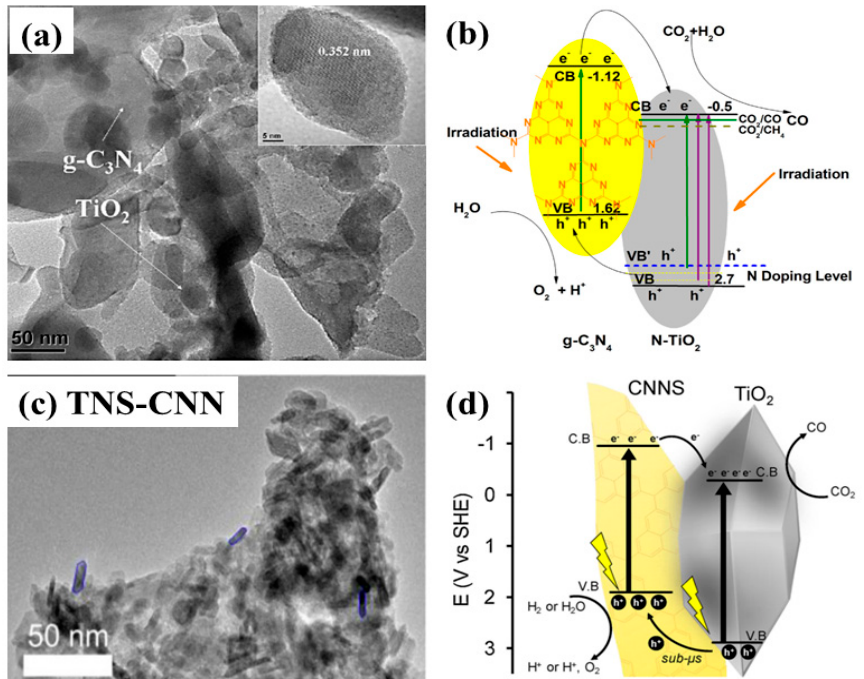
Figure 7. ( a ) TEM image showing the loading of N-TiO 2 nanoparticles onto g-C 3 N 4 nanosheets, and ( b ) proposed scheme involved in photocatalytic CO 2 conversion (taken with permission from [62]). ( c ) TEM image showing the 2-D nanostructure of TiO 2 nanosheets coupled with g-C 3 N 4 nanosheets, and ( d ) schematic view of the interfacial charge transfer within TNS-CNN with the proposed photocatalytic CO 2 conversion mechanism (taken with permission from